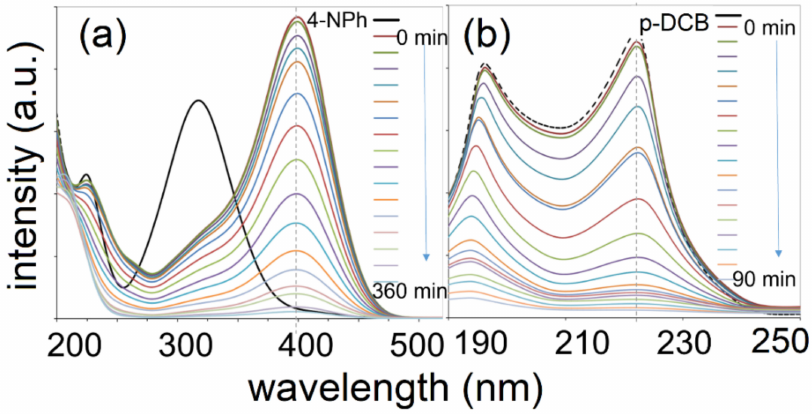
Figure 6. UV − vis absorption spectra of ( a ) 4-NPh; and ( b ) p-DCB solutions in the presence of Ag_MgGaAl and solar irradiation.